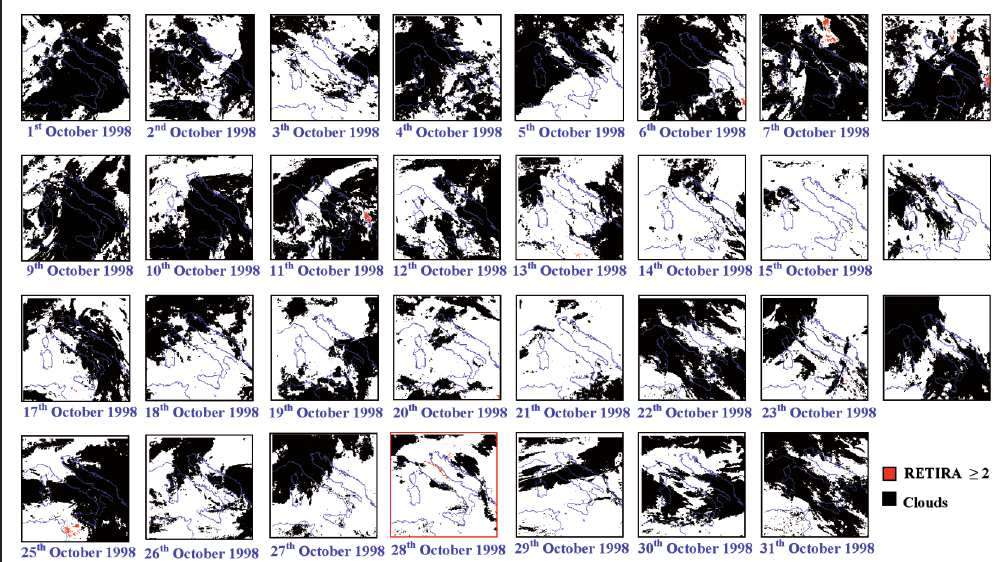
Fig. 5. Confutation: results of the RETIRA index computation on the investigated area; the red bordered im- age (28 th October) is the only one affected by anomalous pixels in the area of interest (see